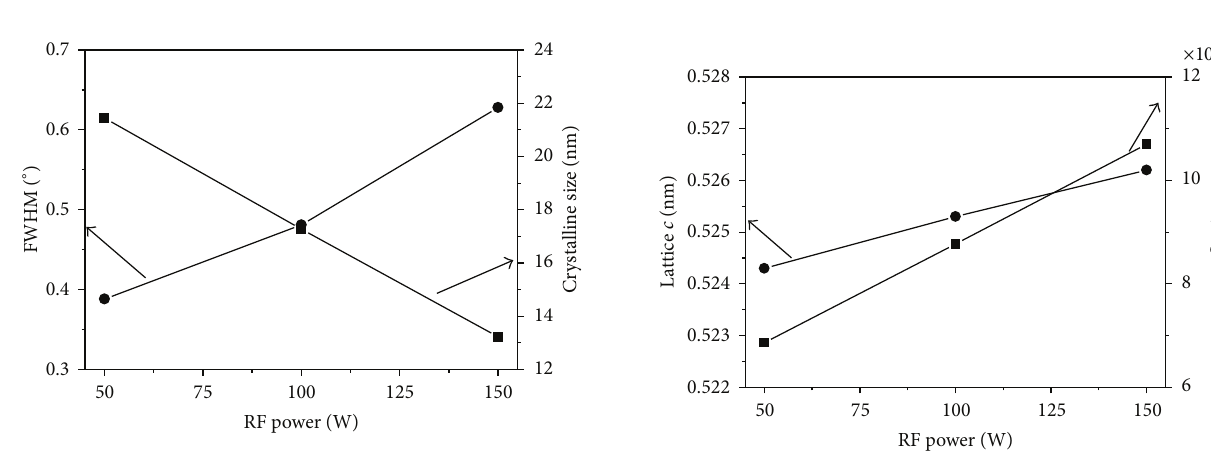
Figure 2: FWHM value and crystalline size of the GZO thin films as a function of deposition power. Figure 3: Lattice constant ( c ) and strain of the GZO thin films as a function of deposition